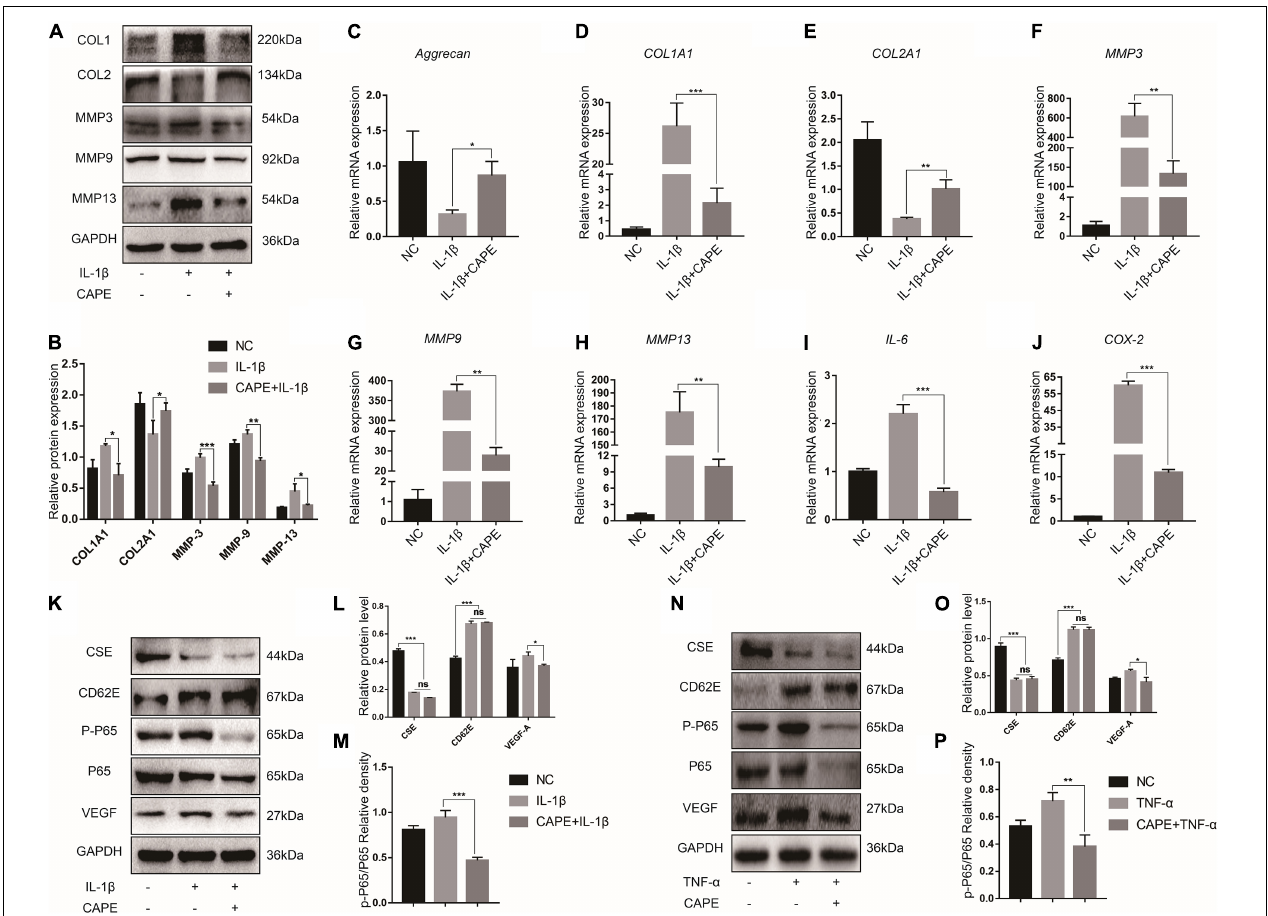
FIGURE 3 | NF- κ B function in IDD. (A) Western blot analysis of MMPs and ECM components and (B) quantification. (C–J) RT-PCR measurement of mRNA levels of ECM-encoding genes, ECM-degrading genes, and secreted inflammatory factors. (K) Representative western blot images of CSE, CD62E, P65, p-P65, and VEGF-A and (L,M) quantification (IL-1 β ). (N) Representative western blot images of CSE, CD62E, P65, p-P65, and VEGF-A and (O,P) quantification (TNF- α